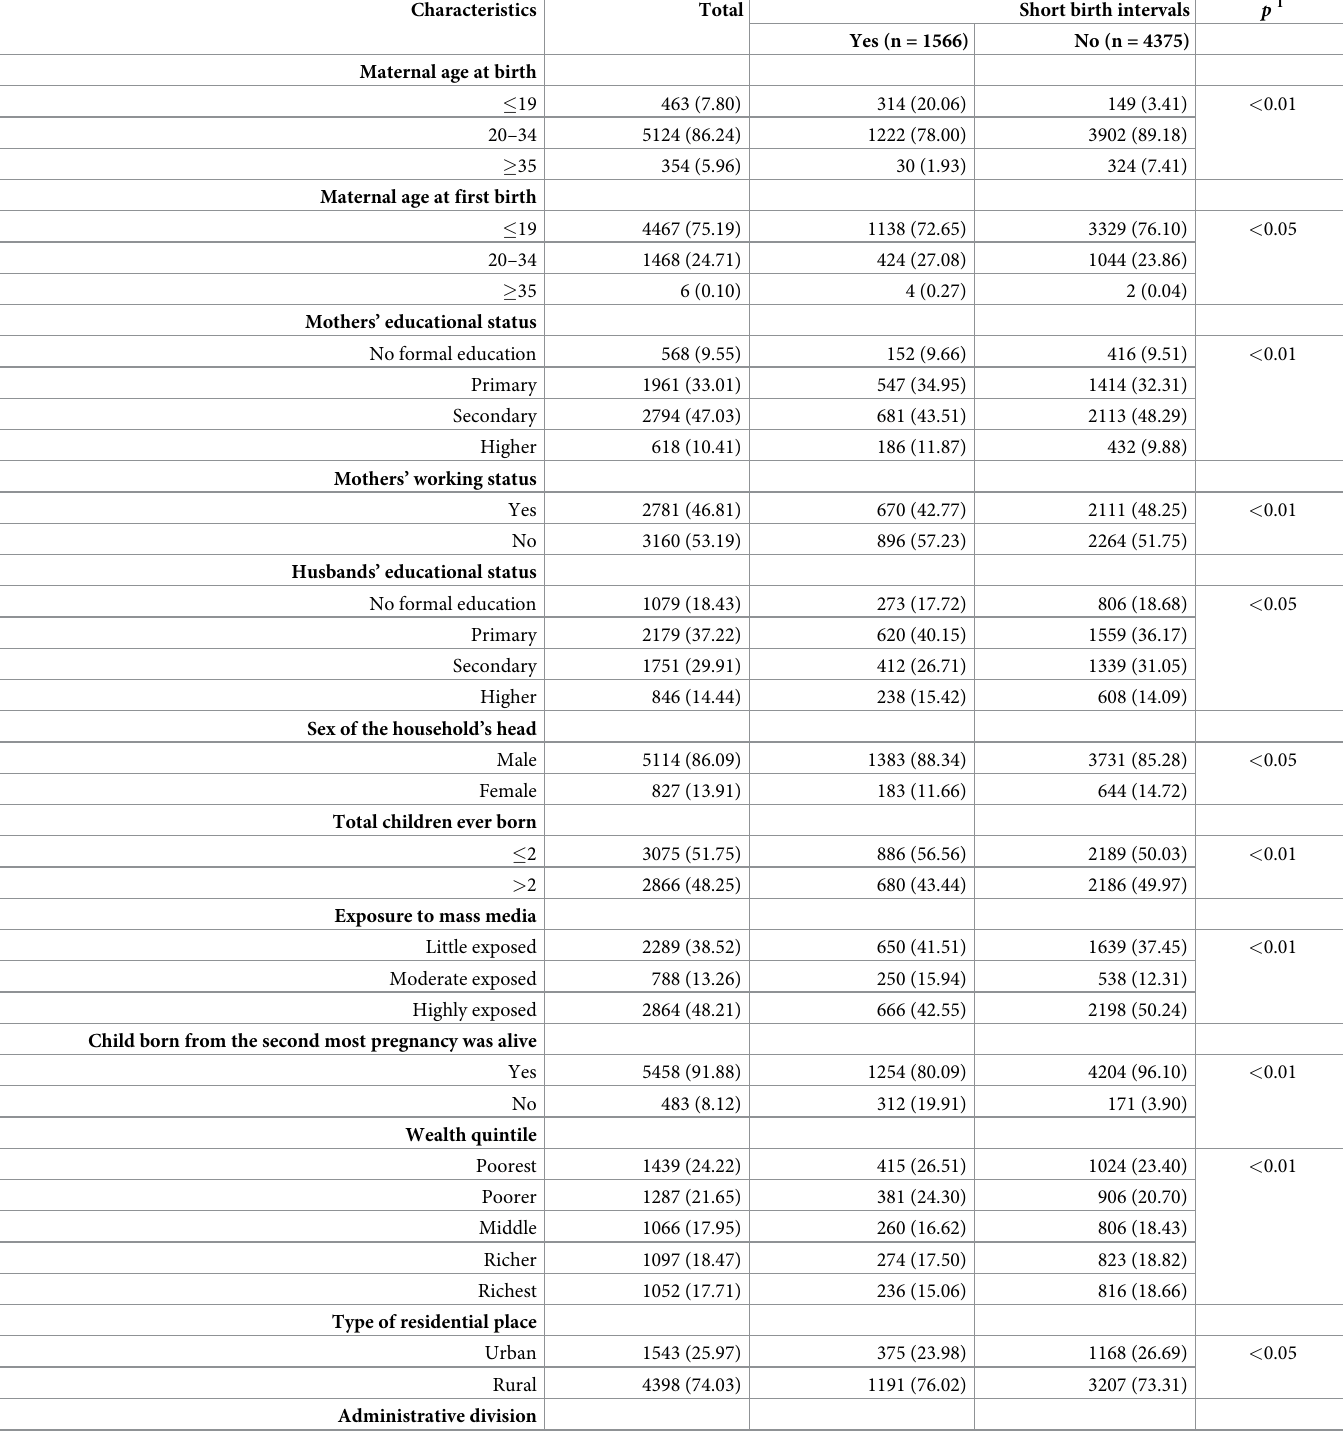
Table 1. Demographic characteristics of the respondents (n =